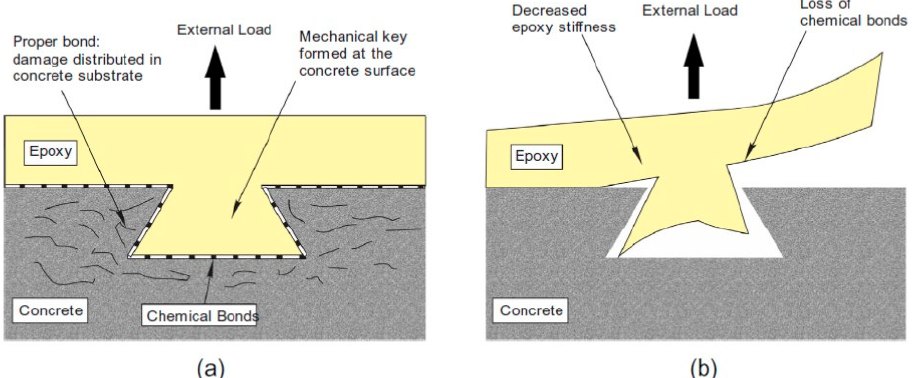
Figure 3. Failure mode of epoxy–concrete bond: ( a ) in dry ambient conditions; ( b ) following exposure to moisture [23]. Reprinted from Construction and Building Materials, 96, Blackburn B.P., Tatar J.,